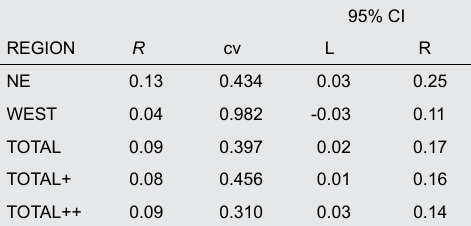
Table 3. Rate of increase ( R ) for blue